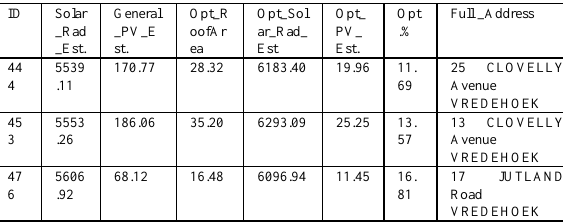
Table 2. Buildings with low photovoltaic potential